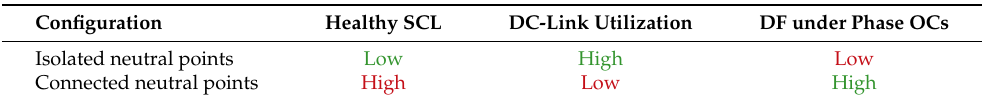
Table 17. Performance for different neutral configurations (Section 4.1.1) for machines with composite n in multiphase applications in the literature [6,20,21,132,278,305]. Configuration Healthy SCL